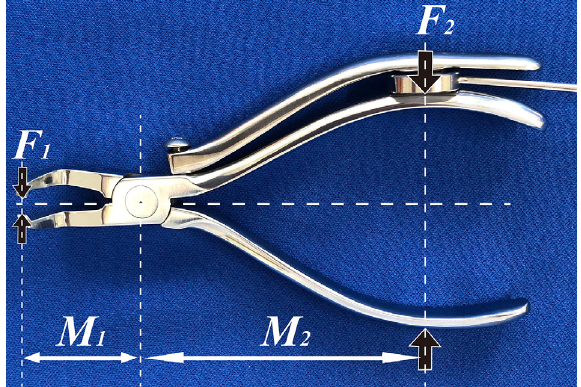
Figure 3- Debonding pliers. A sensor was located between the grip of the pliers and the additional